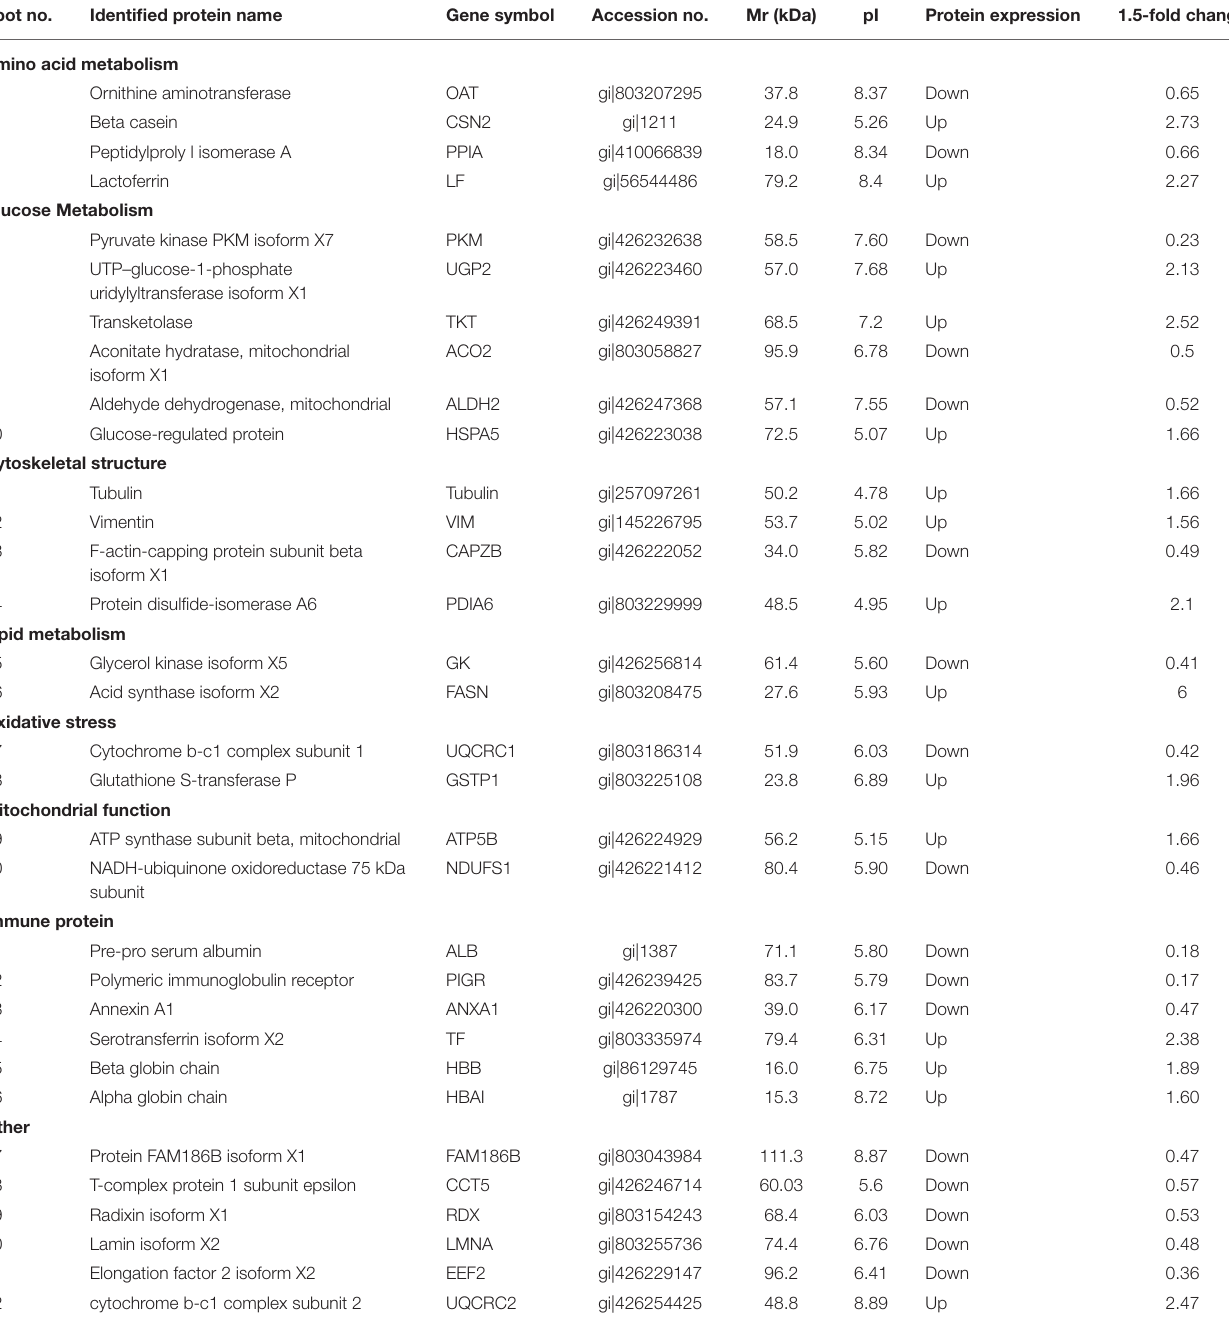
TABLE 4 | Differential expression protein spots by MAIDI-TOF-TOF. Spot